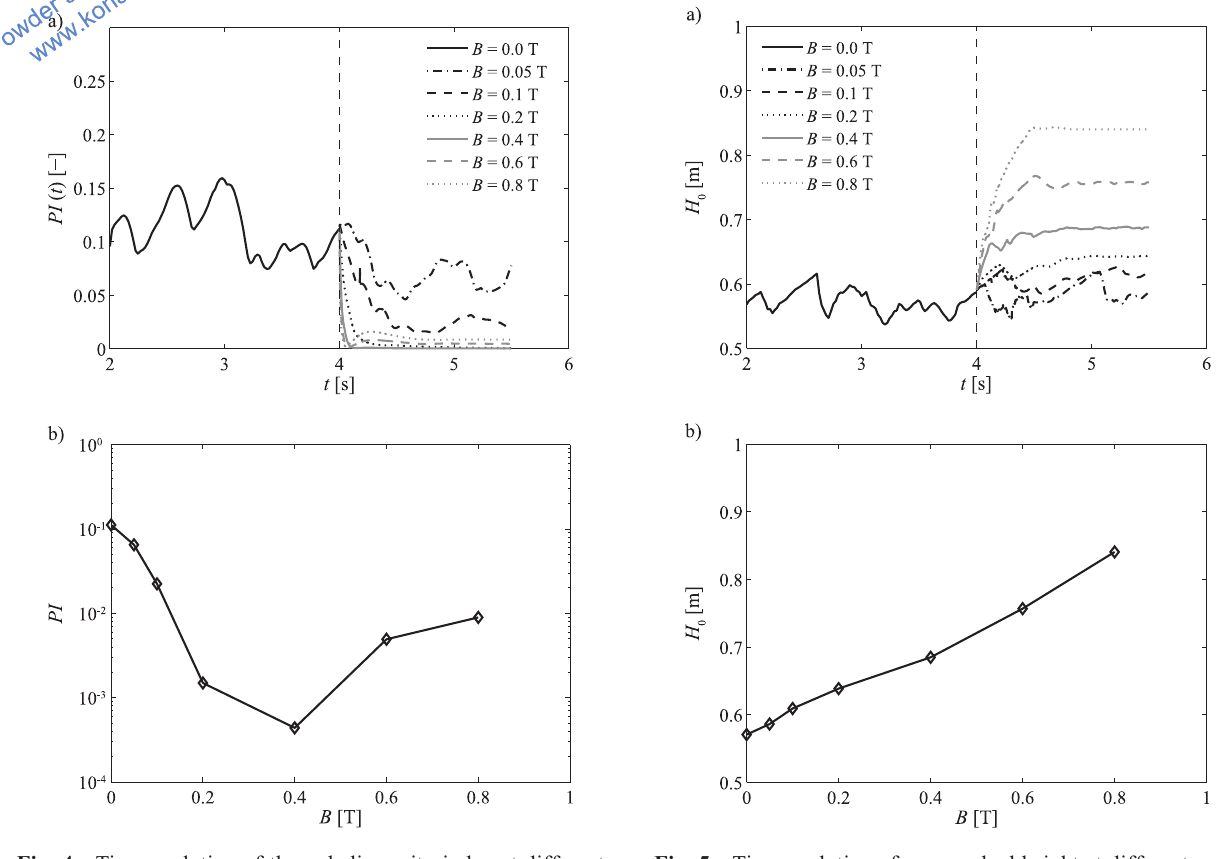
Fig. 5 Time evolution of average bed height at different mag- netic field intensities (a) and relevant time-averaged values (b). d p = 300 µm; U = 2.5 U mf .